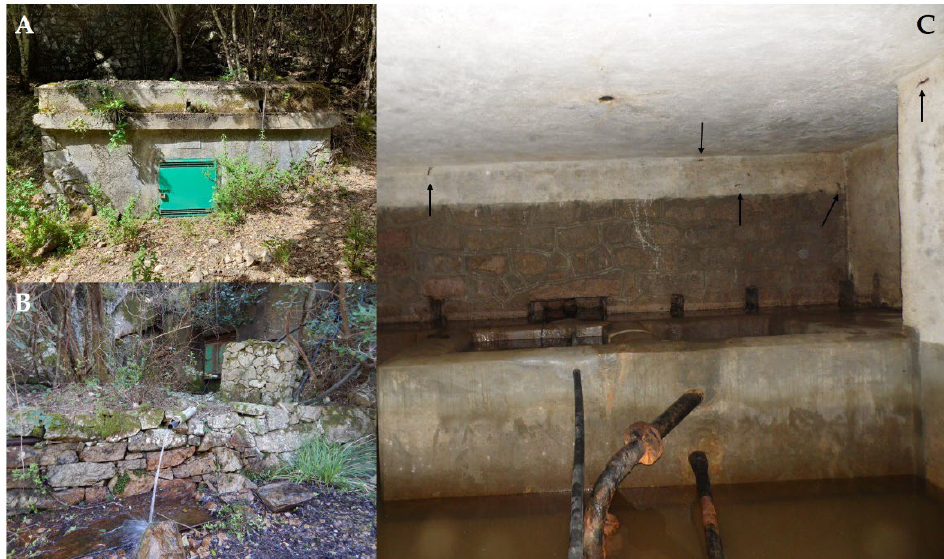
Figure 2. ( A ) and ( B ) show the two artificial springs in which Speleomantes sarrabusensis Figure 2. ( A , B ) show the two artificial springs in which Speleomantes sarrabusensis occurs. In ( C ), it is occurs. In ( C ), it is possible to see part of the inner environment of one spring; arrows are possible to see part of the inner environment of one spring; arrows are pointing to a few individuals pointing to a few individuals that are clinging on the concrete walls. that are clinging on the concrete